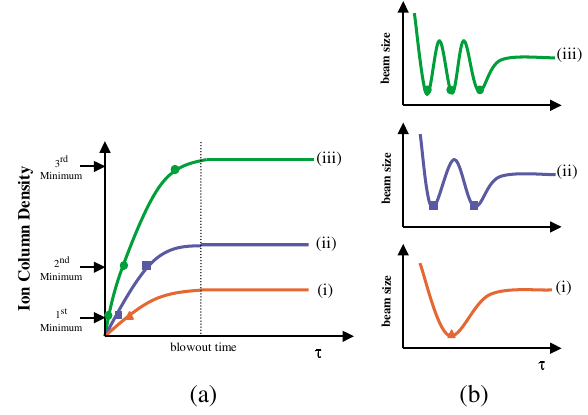
FIG. 2. (Color) (a) A schematic representation of the ion col- umn density along the bunch in time at several ambient plasma densities. The lowest density is line ( i ) and the highest density is line ( iii ). The three arrows along the ion column density axis indicate the density at which the beam is a minimum at the plasma exit. The lowest density has only one focus, while the highest density undergoes three minima. (b) Pictorial repre- sentations for the expected beam sizes at the plasma exit for the three densities given in (a).